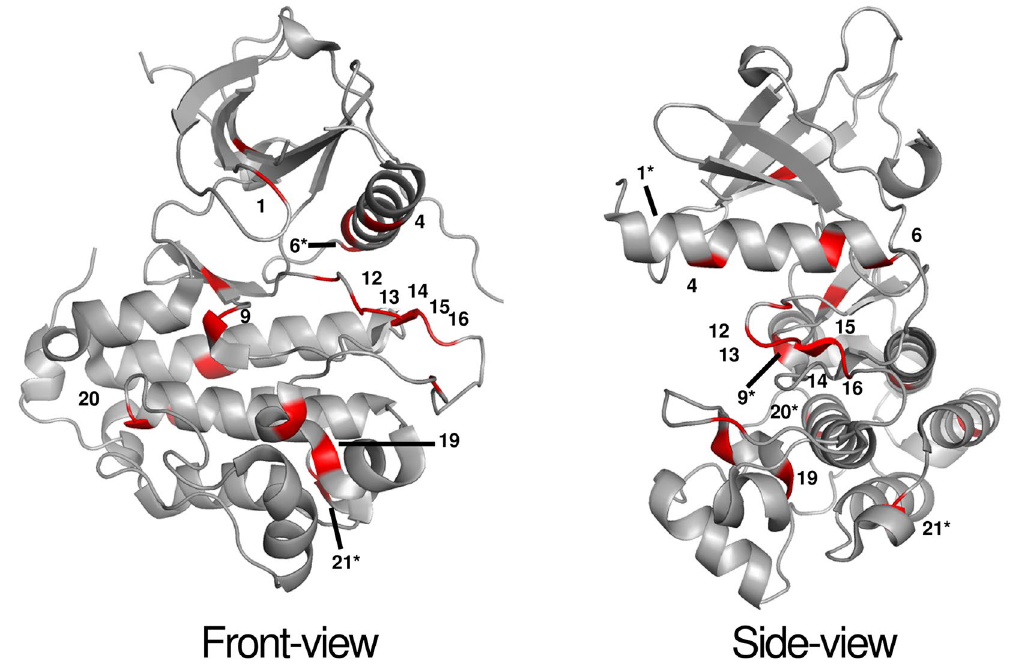
Figure 2. Significantly Mutated Positions as they appear on the EGFR kinase crystal structure. 20 of 23 SMPs which have corresponding positions on the EGFR kinase crystal structure are highlighted in red. Positions bearing well-known functional mutations and mutations to be validated in vitro are labeled following the numbering of Table 1 and include: 1) BRAF G469A / V . 4) TGFBR1 S241L. 6) ERBB2 V777L , ALK F1174L/C/V/I . 9) KDR R1032Q. 12) EGFR L858R , TGFRB1 L354P. 13) CHEK2 S372F/Y. 14) ALK R1275Q , ERBB2 R868W, CHEK2 K373E. 15) BRAF V600E , EGFR L861Q / R , FLT3 D835Y / V / H / E . 16) BRAF K601E , FLT3 I836M / H . 19)